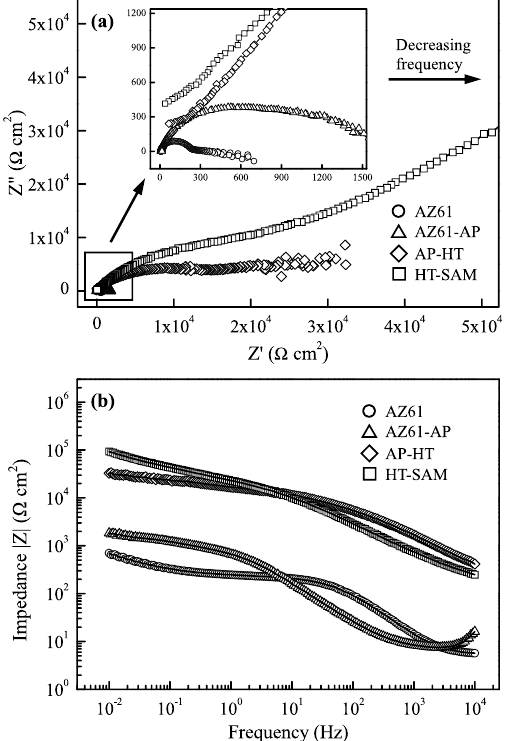
Figure 7. ( a ) Nyquist plots and ( b ) Bode plots of the impedance magnitude of the AZ61 Mg alloy, AZ61-AP, AP-HT and HT-SAM specimens tested in R-SBF at 37 °C.